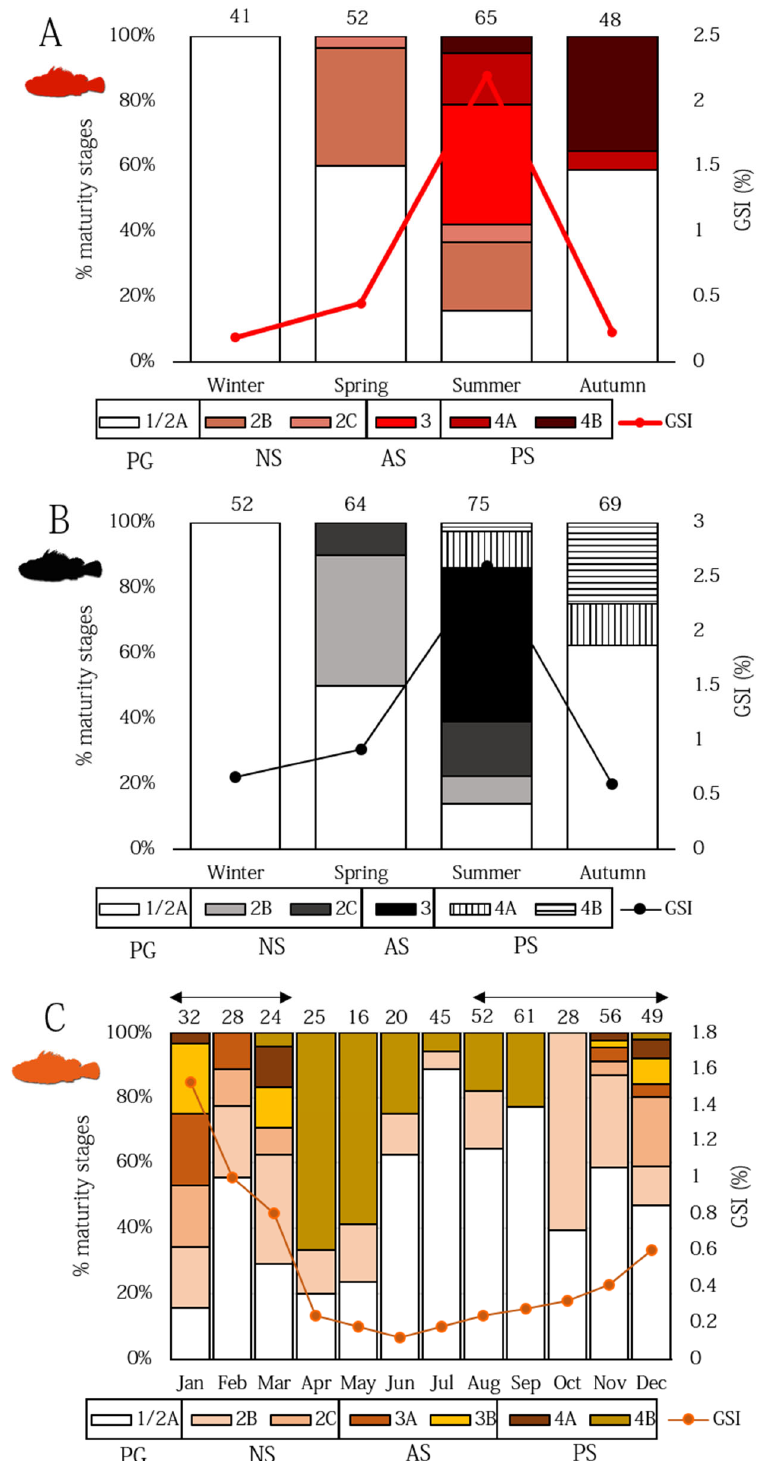
Figure 7. Proportions of Scorpaena scrofa ( A ), Scorpaena porcus ( B ), and Helicolenus dactylopterus ( C ) females in relation to their gonadal growth stage (PG, primary growth; NS, non-spawning; AS, actively spawning; PS, post-spawning). S. scrofa and S. porcus were described per season, while H. dactylopterus per month. The evolution of the gonado–somatic index (GSI (%)) is also represented. The double-headed arrow in Figure 7C indicates the presence of spermatic crypts inside the ovaries. Above each season or month, the number of analyzed females is reported.